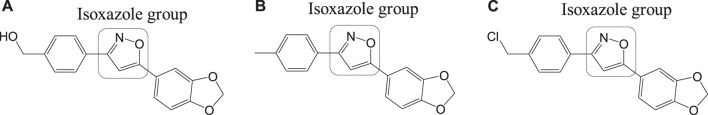
Potent anti-Chagas isoxazole-derived drugs that target trypanothione reductase.